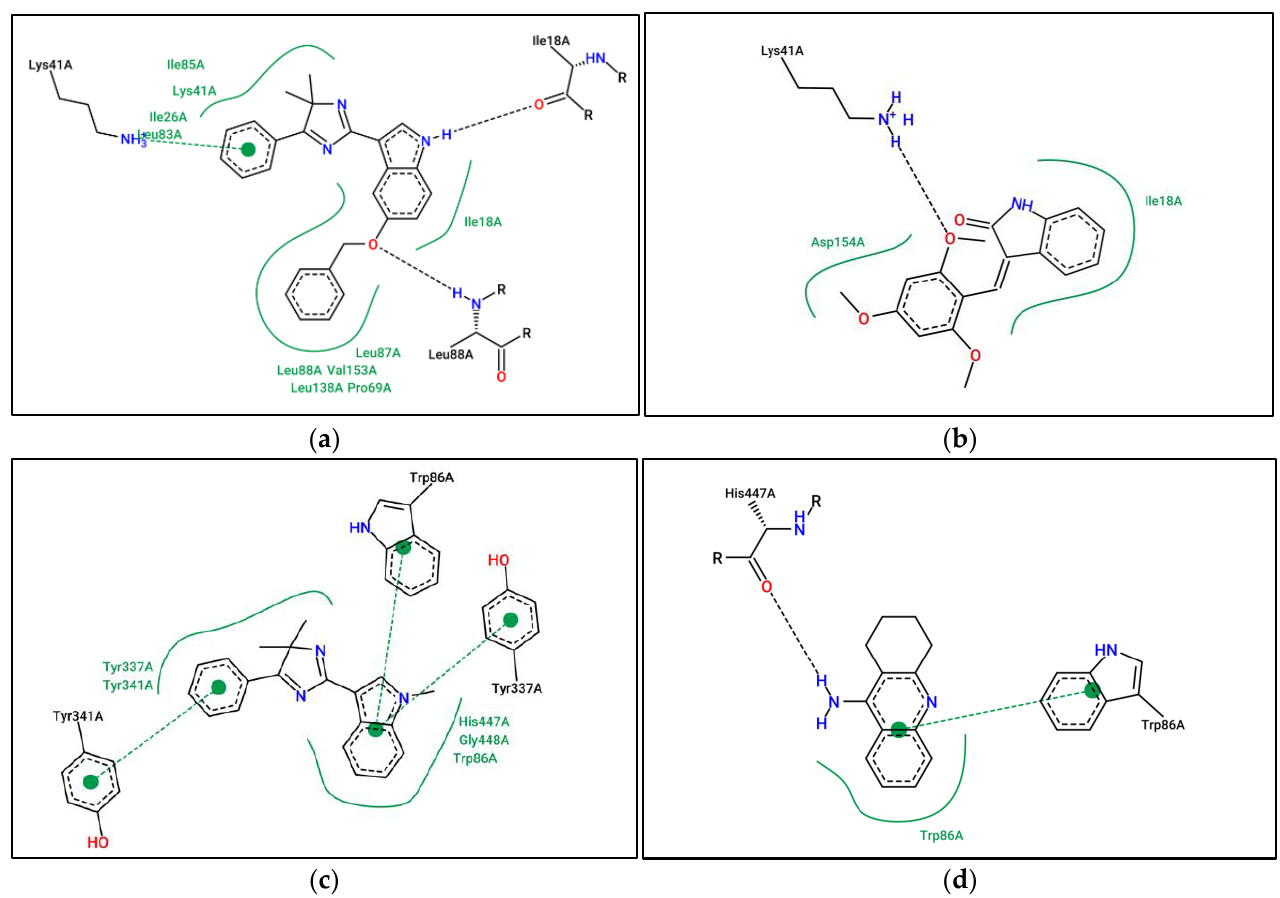
Figure 5. Two-dimensional maps of non-covalent interactions of ligands: ( a ) 5b in CK1δ; ( b ) native inhibitor of CK1δ; ( c ) 5a in AChE; ( d ) native ligand inhibitor of AChE.